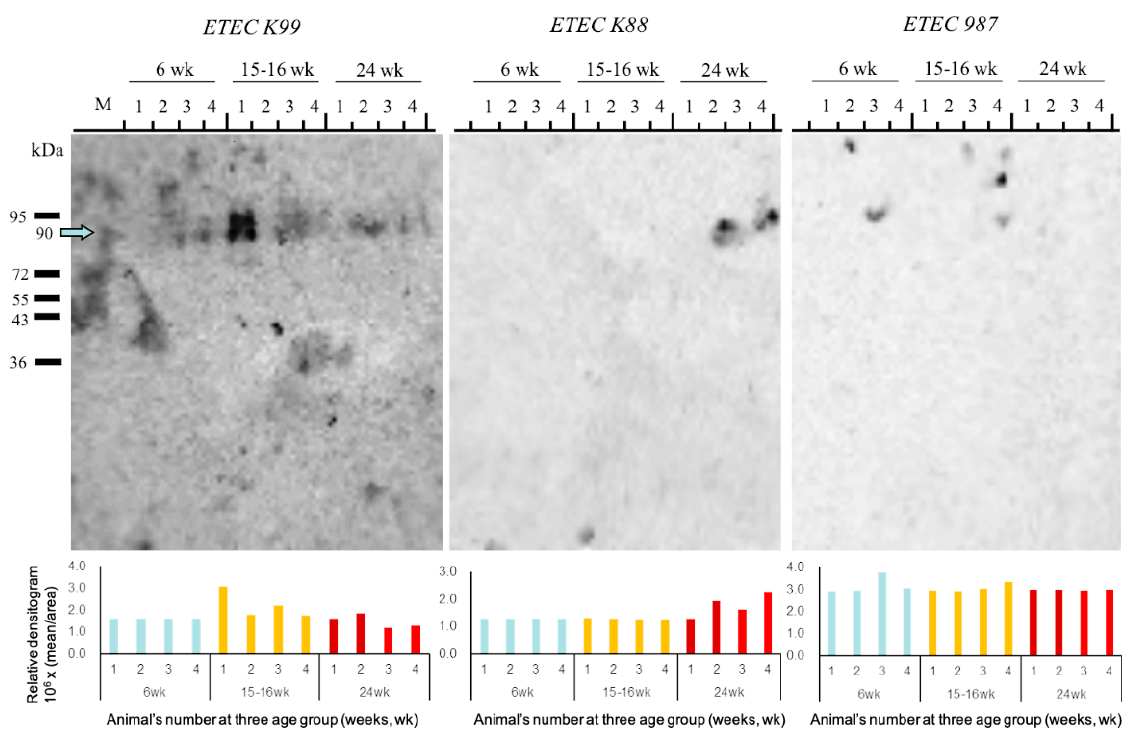
Figure 4. Western blot analysis for the detection of Enterotoxigenic E. coli (ETEC) strains in the feces of study